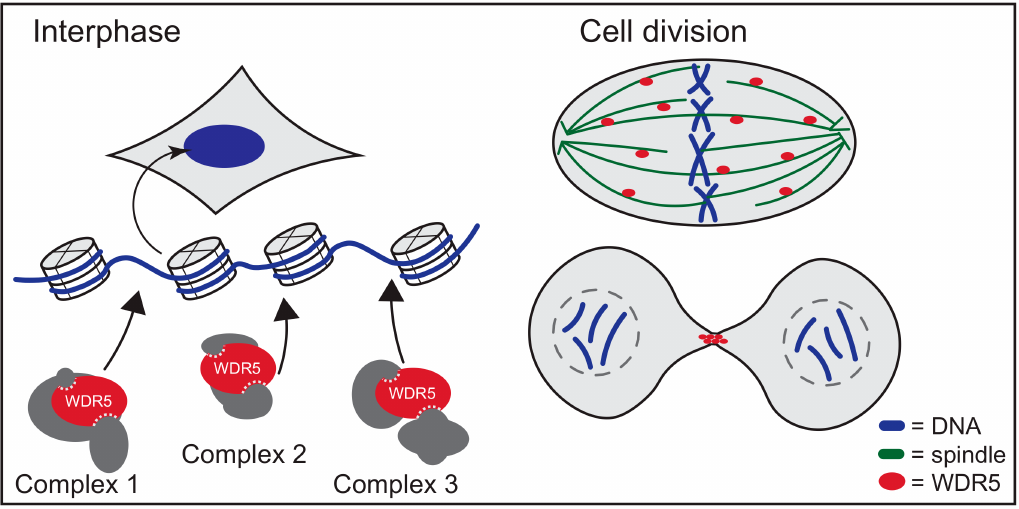
Figure 7. WDR5 performs roles at chromatin and roles in cell division. In addition to assembling in multiple complexes at chromatin during interphase, WDR5 functions at the spindle and midbody of dividing cells to facilitate the integrity of mitosis and